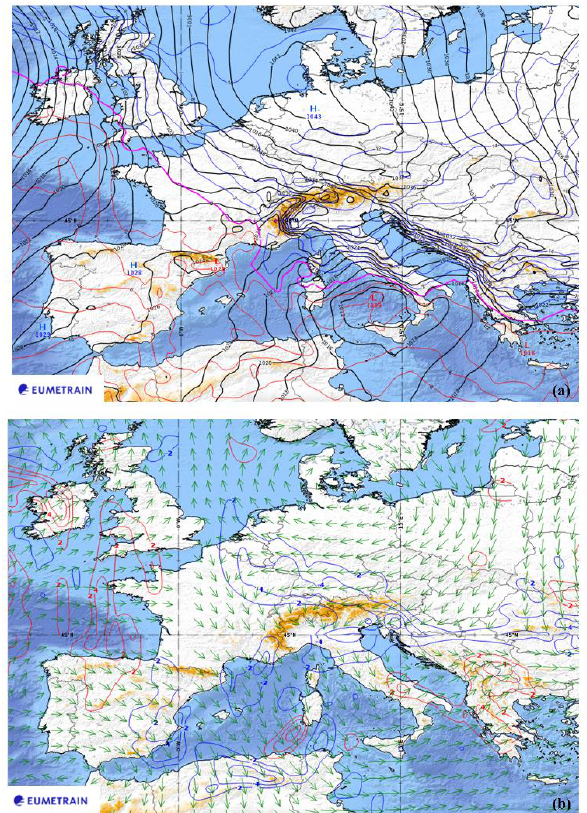
Figure 12. In the upper panel ( a ), the 850 hPa temperature (in ◦ C) and the sea level pressure (in hPa) fields on 13 February 2021, 12:00 UTC are presented. The 850 hPa temperature is shown as blue (negative values), red (positive values) and magenta (0 ◦ C isotherm) contour with an interval of 2 ◦ C, whereas the sea level pressure is sketched as a black contour with an interval of 2 hPa. In the bottom panel ( b ), for the same event, the 700 hPa winds, shown as green arrows, and the temperature advection (in ◦ C) are shown. The temperature advection is expressed as blue (negative values) and red (positive values) contours with an interval of 2 ◦ C. All fields are numerical model outputs and they were retrieved from the European Centre for Medium Range Weather Forecast (ECMWF) archive, available through the EUMeTrain ePort Pro website [67].